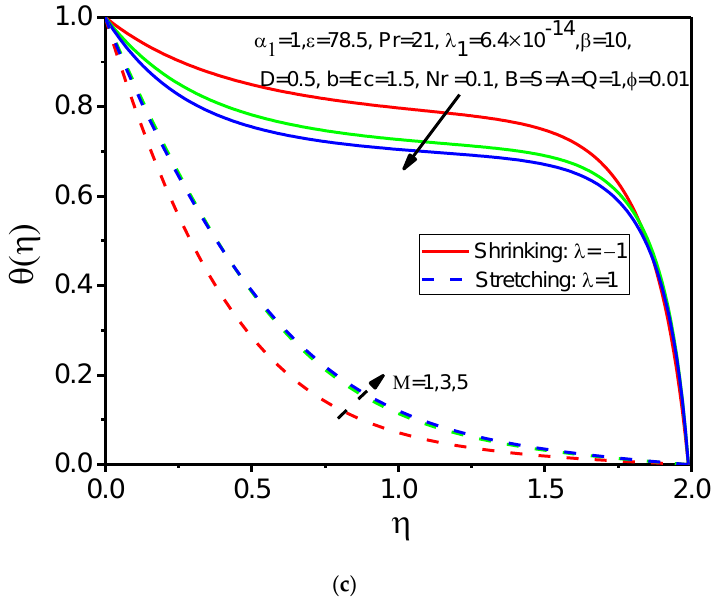
Figure 6. Variation of M on ( a ) Velocity profile, ( b ) Pressure profile, ( c ) Temperature profile. The combined effect of stretching and shrinking case for various values of curvature parameter on velocity, pressure and temperature distributions is plotted in Figure 7. It is well known that the radius of the cylinder decreases as the values of the curvature param- eter is enhanced. As a result, less resistance is provided on the cylindrical surface which increases the fluid velocity in the boundary layer region, and this can be observed from Figure 7a in both stretching and shrinking cases. Two different types of configuration are found in the pressure profiles (see Figure 7b), where we see that pressure is effectively increased and decreased for cases of stretching and shrinking, respectively. However, this influence is reversed on the temperature distribution.